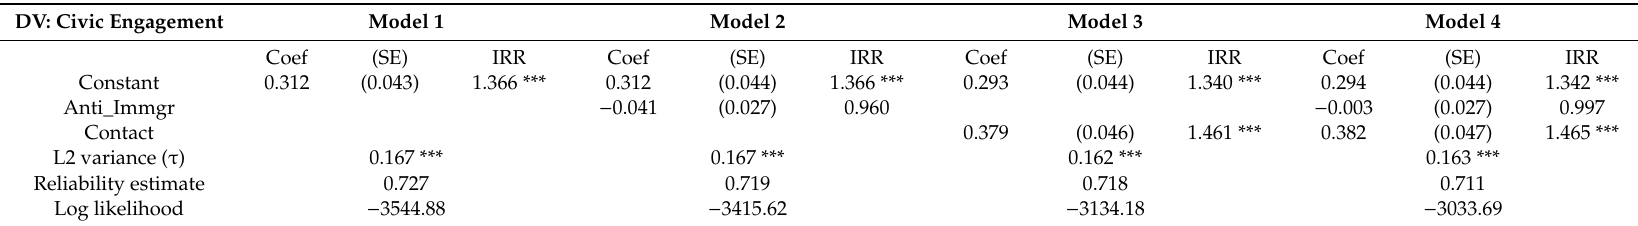
Table 3. Multilevel Poisson Regression Analysis (Caucasus Barometer 2017 Georgia. Caucasus Research Resource Center CRRC).